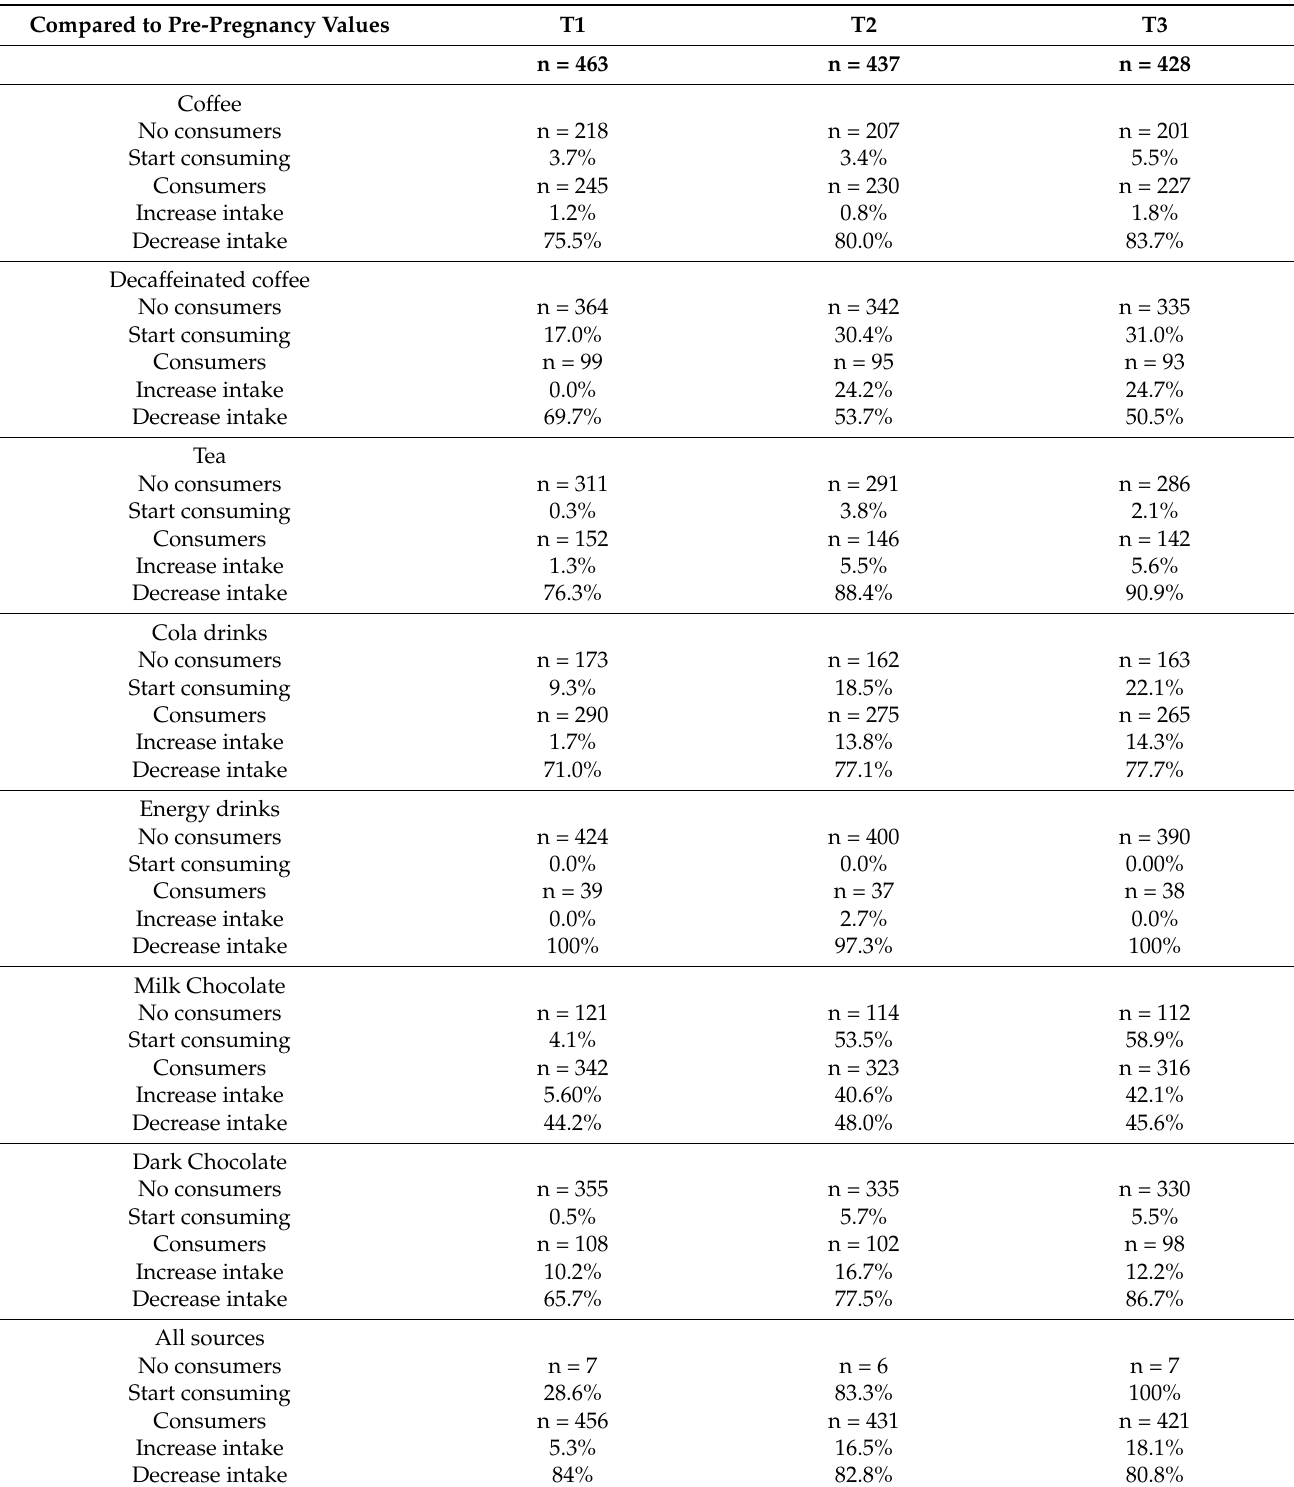
Table 2. Frequencies of women starting, increasing, or decreasing the amount of caffeine intake throughout pregnancy, compared to